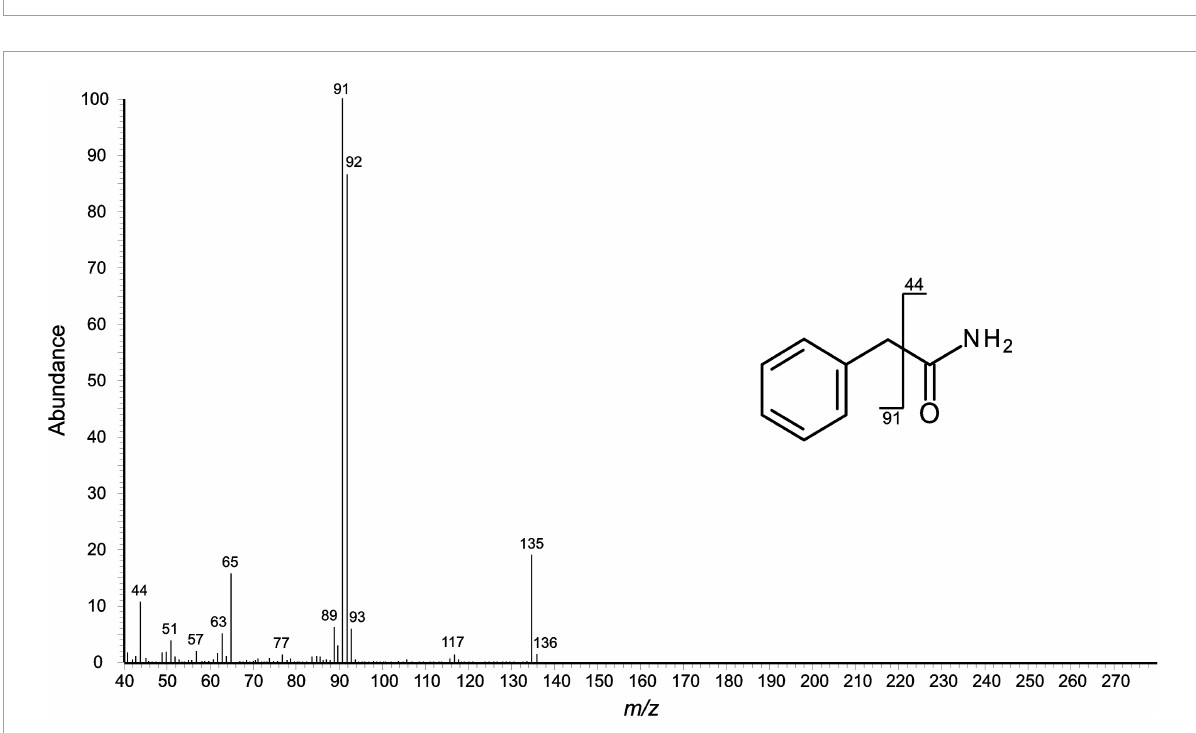
FIGURE9 Mass spectral (EI) fragmentation of aromatic compound F (2-phenylacetamide) from Nelima narcisi . Fragment ions from α -cleavage can be seen at m/z 44; the fragment at m/z 91 indicates benzylic